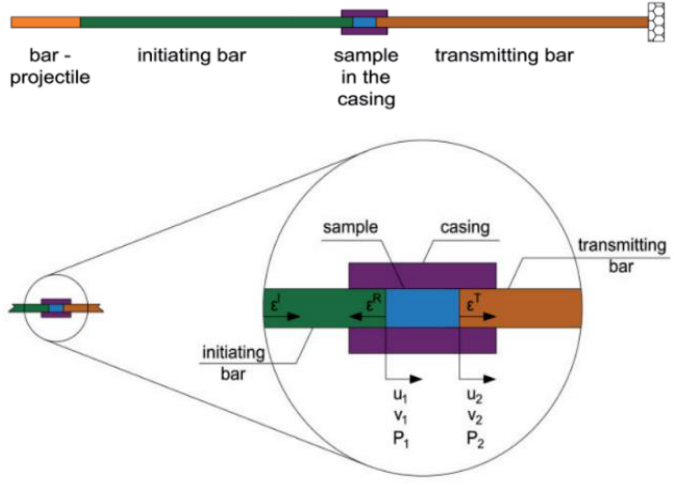
Figure 21. Detailed view with the sample in contact with the fronts of both measuring bars (reprinted from Ref. [71]).